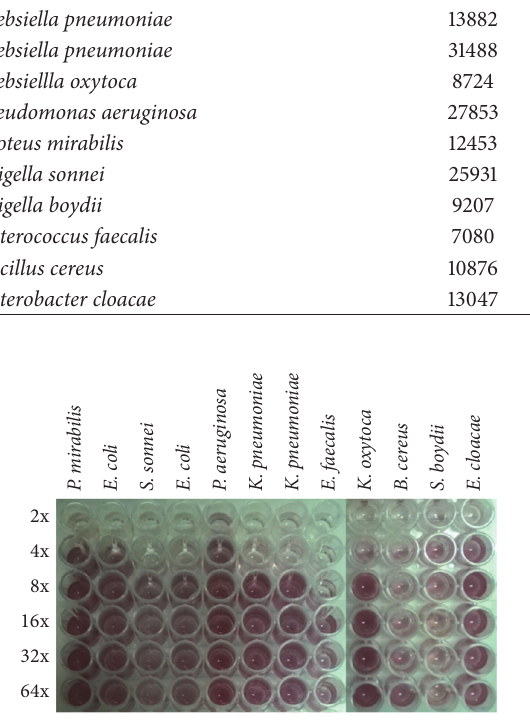
Figure 3: Example of a typical 96-well micro titre plate layout used for testing the nanocomposites. The clear wells show inhibition of bacterial growth and the purple wells indicate active cells reducing the